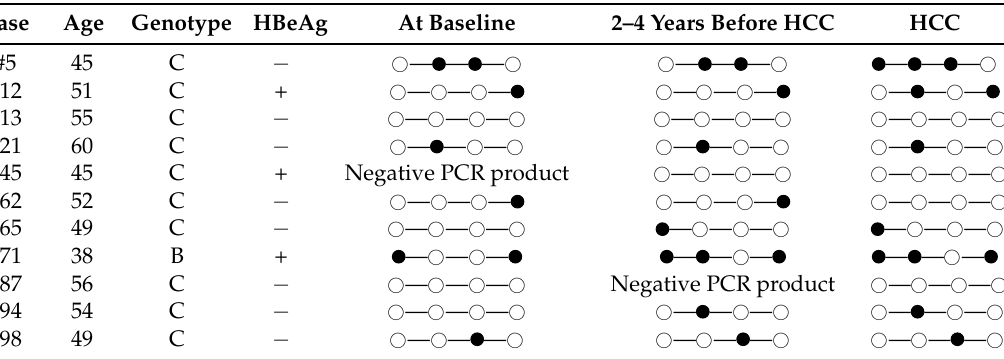
Table 6. Longitudinal observation of C gene mutation patterns in 11 HCC